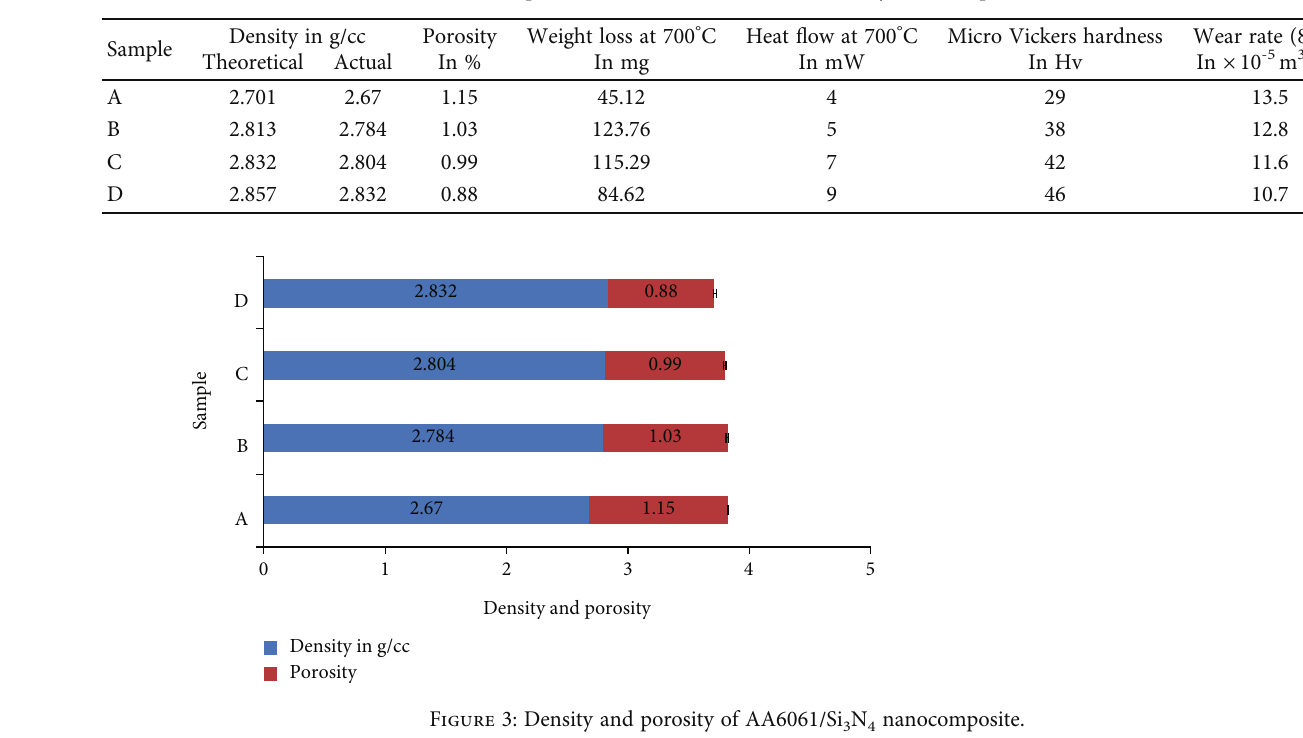
Figure 2: Phase transformation diagram for AA6061/Si Table 4: Experimental test results for AA6061 alloy nanocomposite.